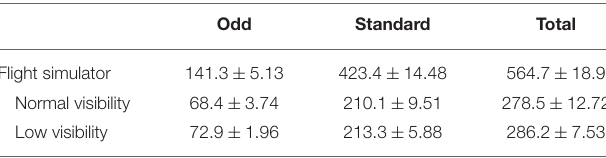
TABLE 1 | The average number of sounds ( ± SEM) presented to the participants during flight simulation for each